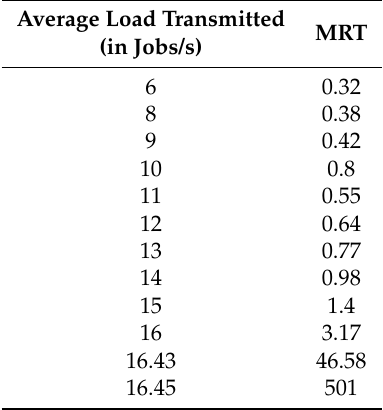
Table 4. Results recorded when executing the DRB scheme to examine the average latency.